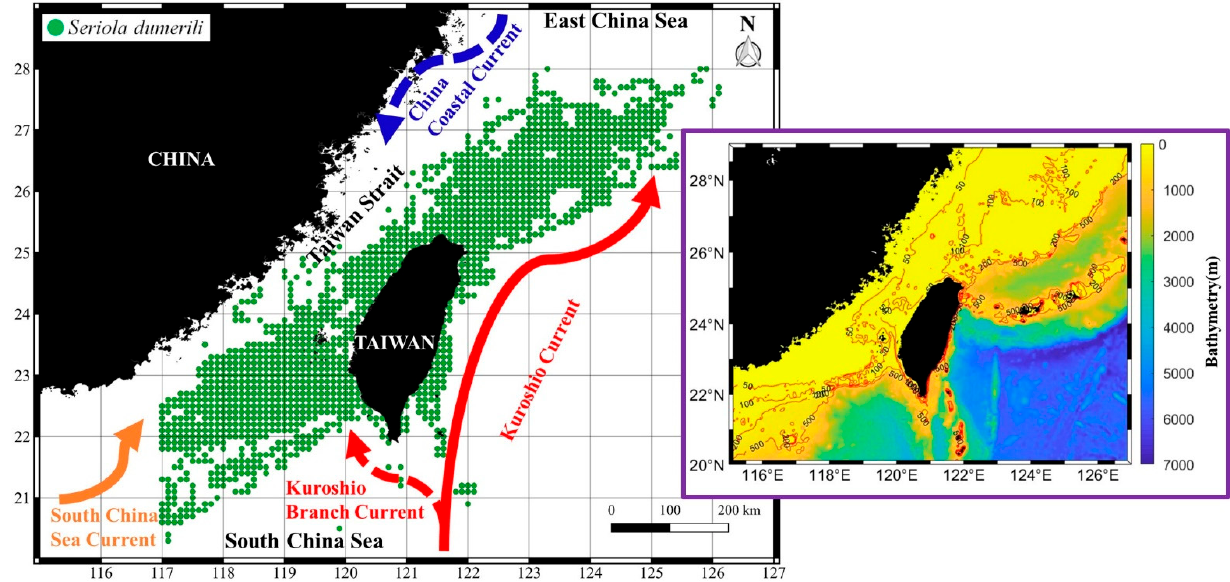
Figure 1. Spatial distribution pattern of S. dumerili caught using angling gear from 2014 to 2017 in the Taiwan Strait (TS). On the right side is a highlighted map of topographic features of bathymetry representing the isobaths, as shown by the orange line.